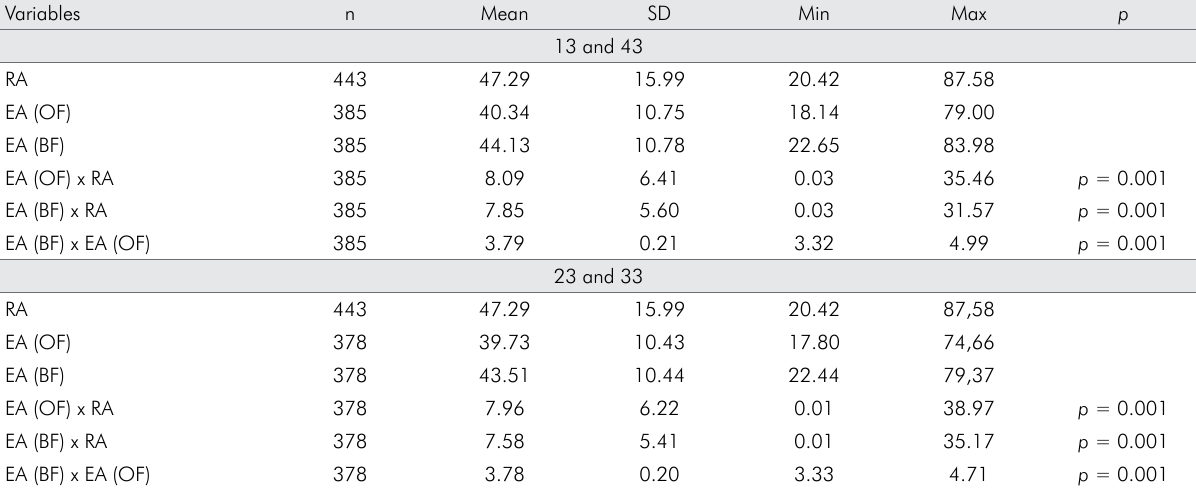
Table 2. A descriptive analysis and comparisons among real ages (RA) and estimated ages (EA) by evaluating right (13 and 43) and left canines (23 and